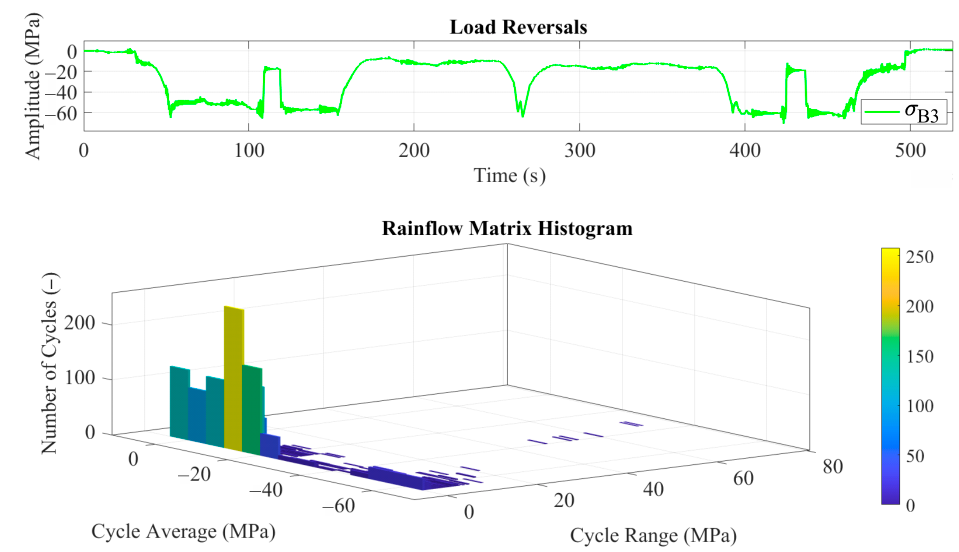
Figure 11. Spectrum of stress amplitudes, Mode 3.